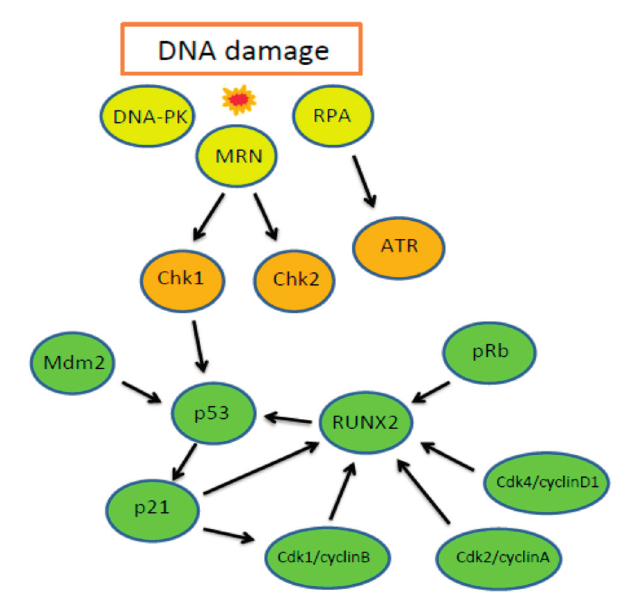
Figure 2. Signaling cascade following DNA damage and important role of